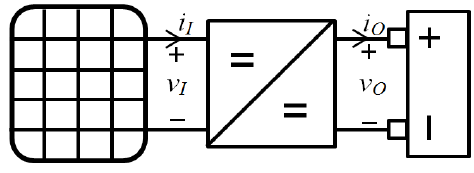
Figure 2. Single solar array single battery